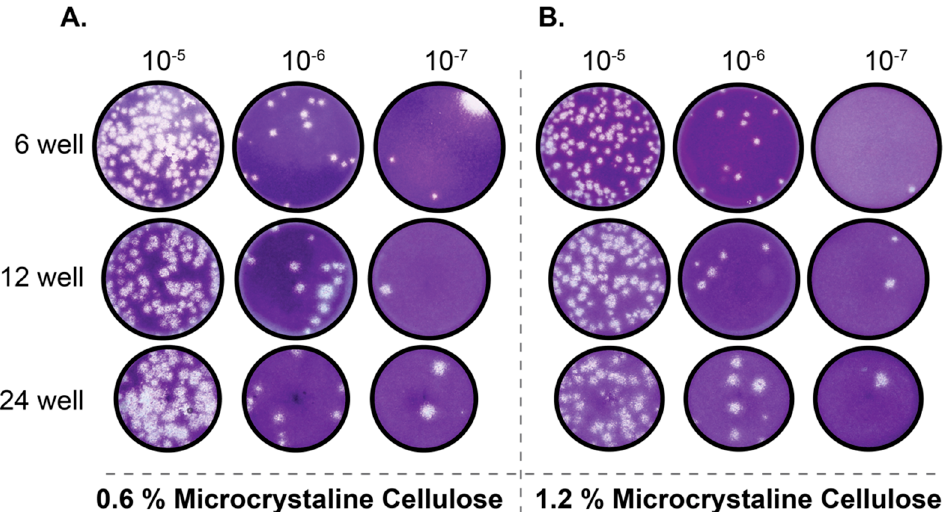
Figure 2. MCC is a suitable alternative as an overlay medium for SARS-CoV-2 plaque assays. Vero E6 cells were infected with serially diluted SARS-CoV-2 stock virus and overlaid with 0.6% ( A ) or 1.2% ( B ) MCC in serum free DMEM. After 72 h, the MCC overlay was removed and monolayer were fixed and stained with crystal violet to visualize plaques.